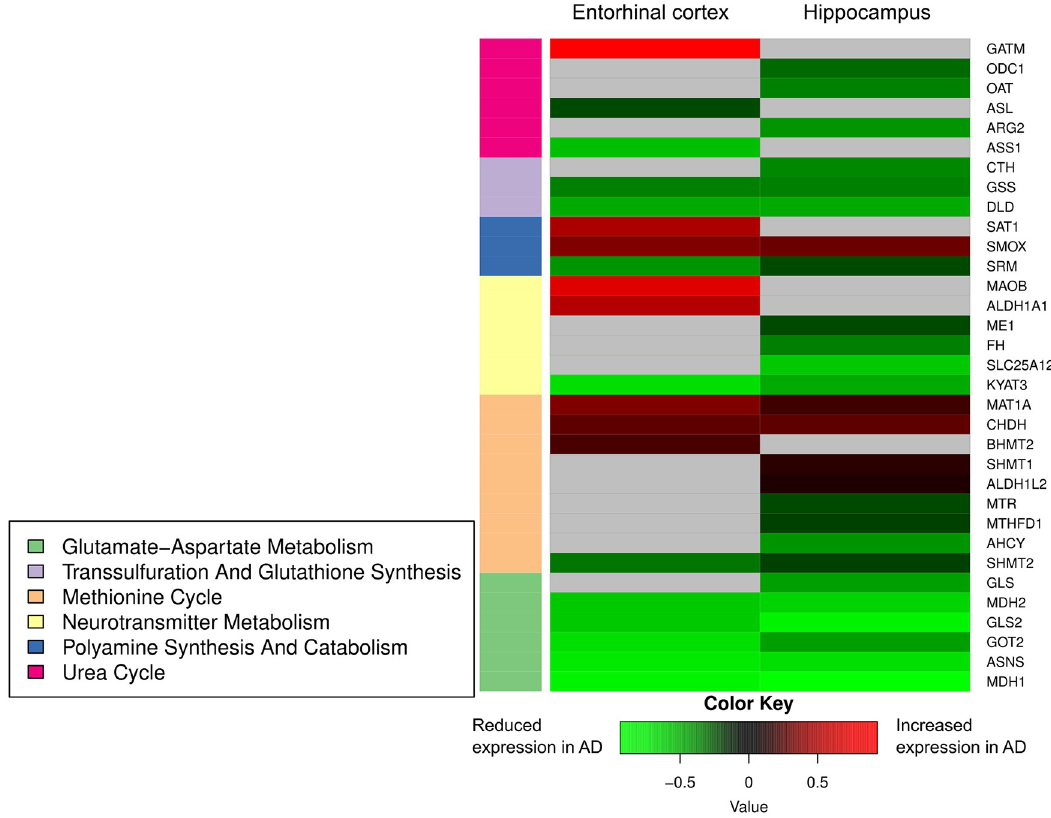
Fig 10. Differential gene expression within ERC and hippocampus. Summary of genes differentially expressed in the hippocampus/ERC in AD compared to controls across all six categories of biochemical reactions related to transmethylation and polyamine metabolism. Gray shading indicates gene expression was not significantly different between AD and control. AD, Alzheimer disease; CN, Control; ERC, entorhinal cortex.